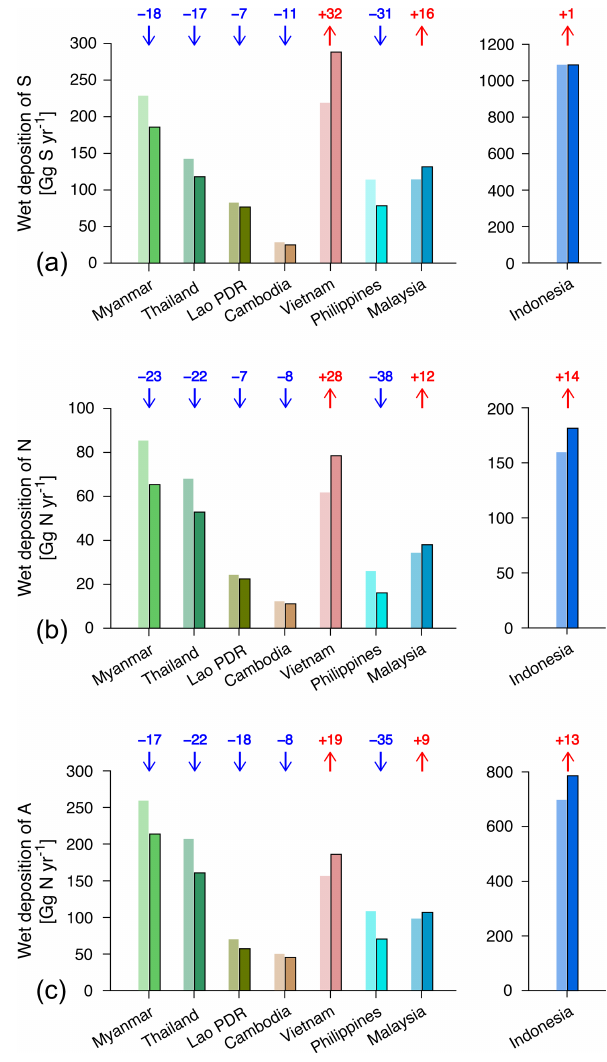
Figure 18. Simulated annual accumulated wet deposition amounts of (a) S, (b) N, and (c) A over southeast Asian countries calculated by ENS (light bars without outlines) and AS (dark bars outlined in black). Blue numbers with down-facing arrows indicate downward revision by AS and red numbers with upward-facing arrows indicate upward revision by